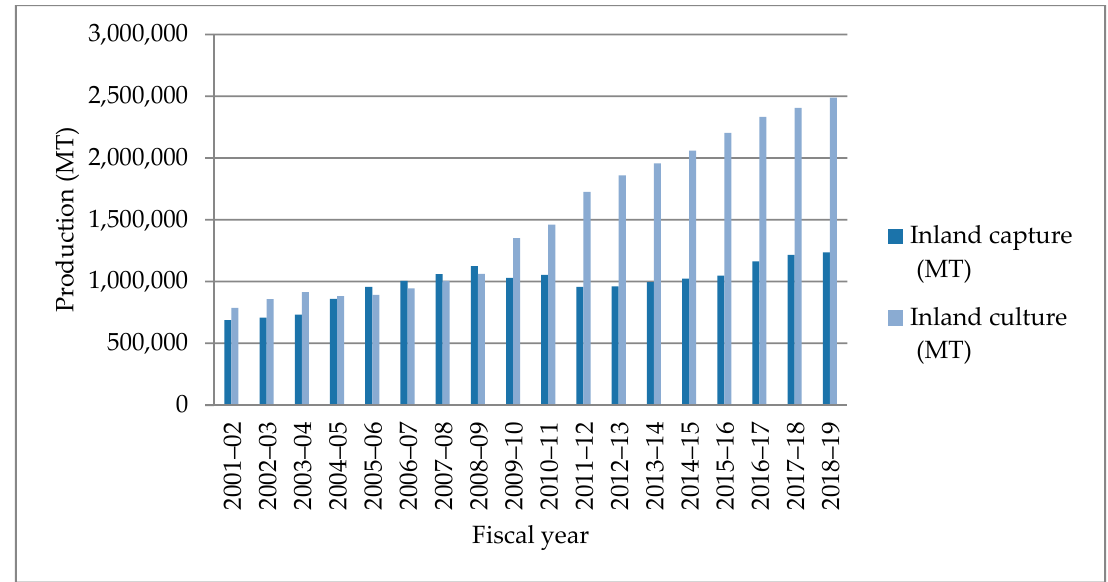
Figure 1. Contribution trend of inland capture and culture fisheries [5,6].